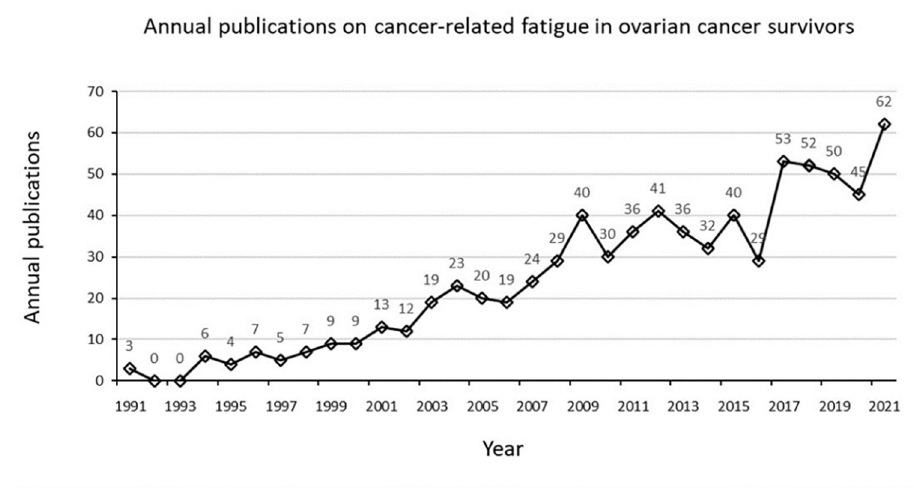
Fig 1. Annual publications on cancer-related fatigue in ovarian cancer